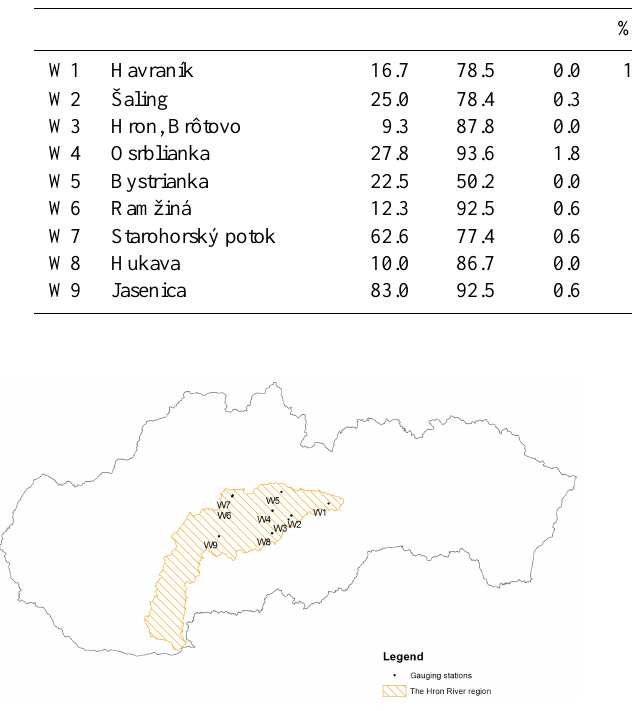
Table 1. Characteristics of the watersheds analysed in the Upper Hron River Basin. N.